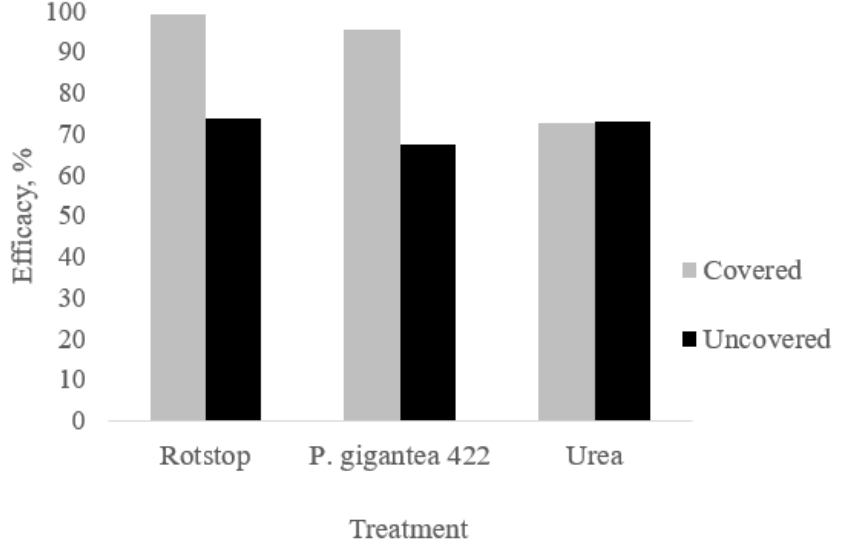
Figure 1. Control efficacy (%) against Heterobasidion spp. based on the relative area of colonized